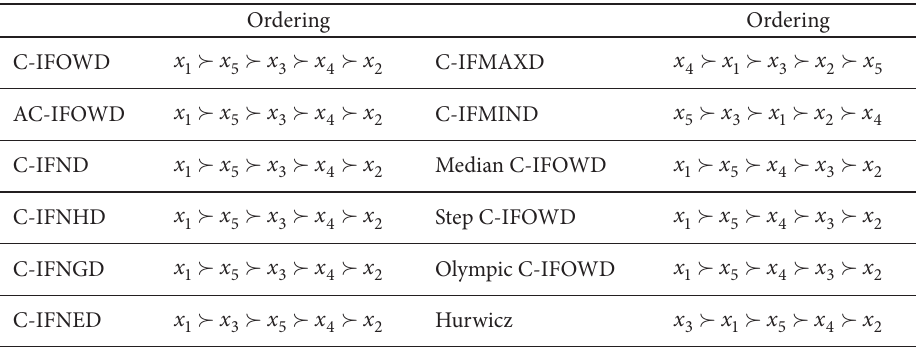
Table 12. Ordering of the